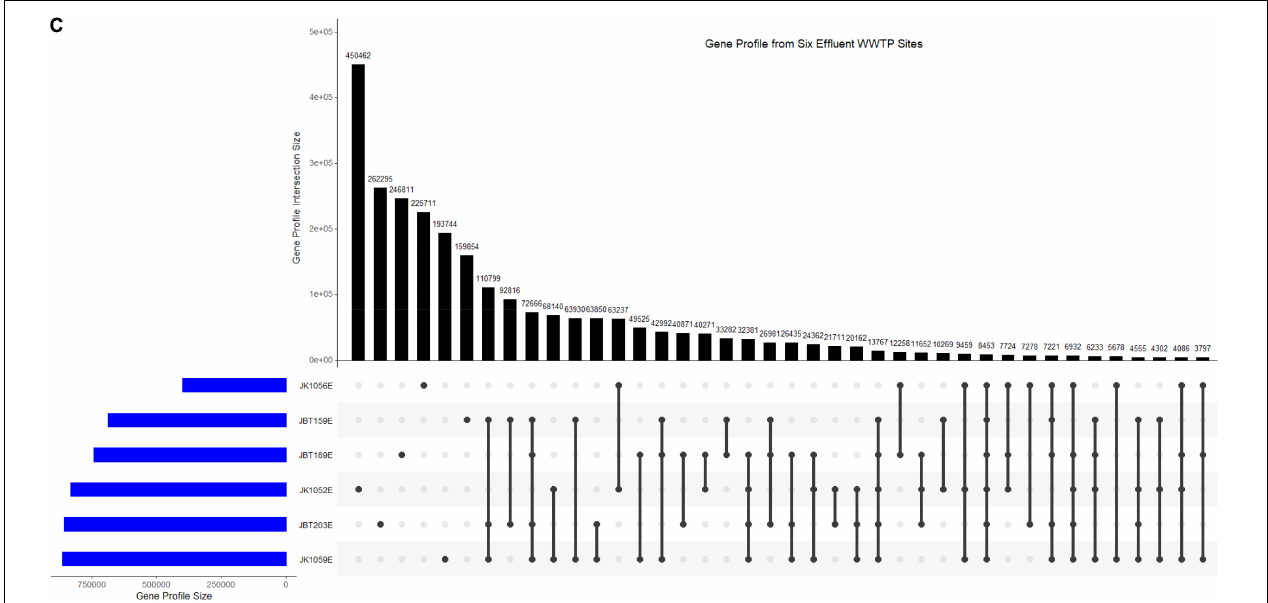
FIGURE 2 | (A) Venn diagram consisting of two sets of groups: influent (blue) and effluent (yellow). The UpSet R plots of the gene profile from (B) six influent and (C) six effluent WWTP